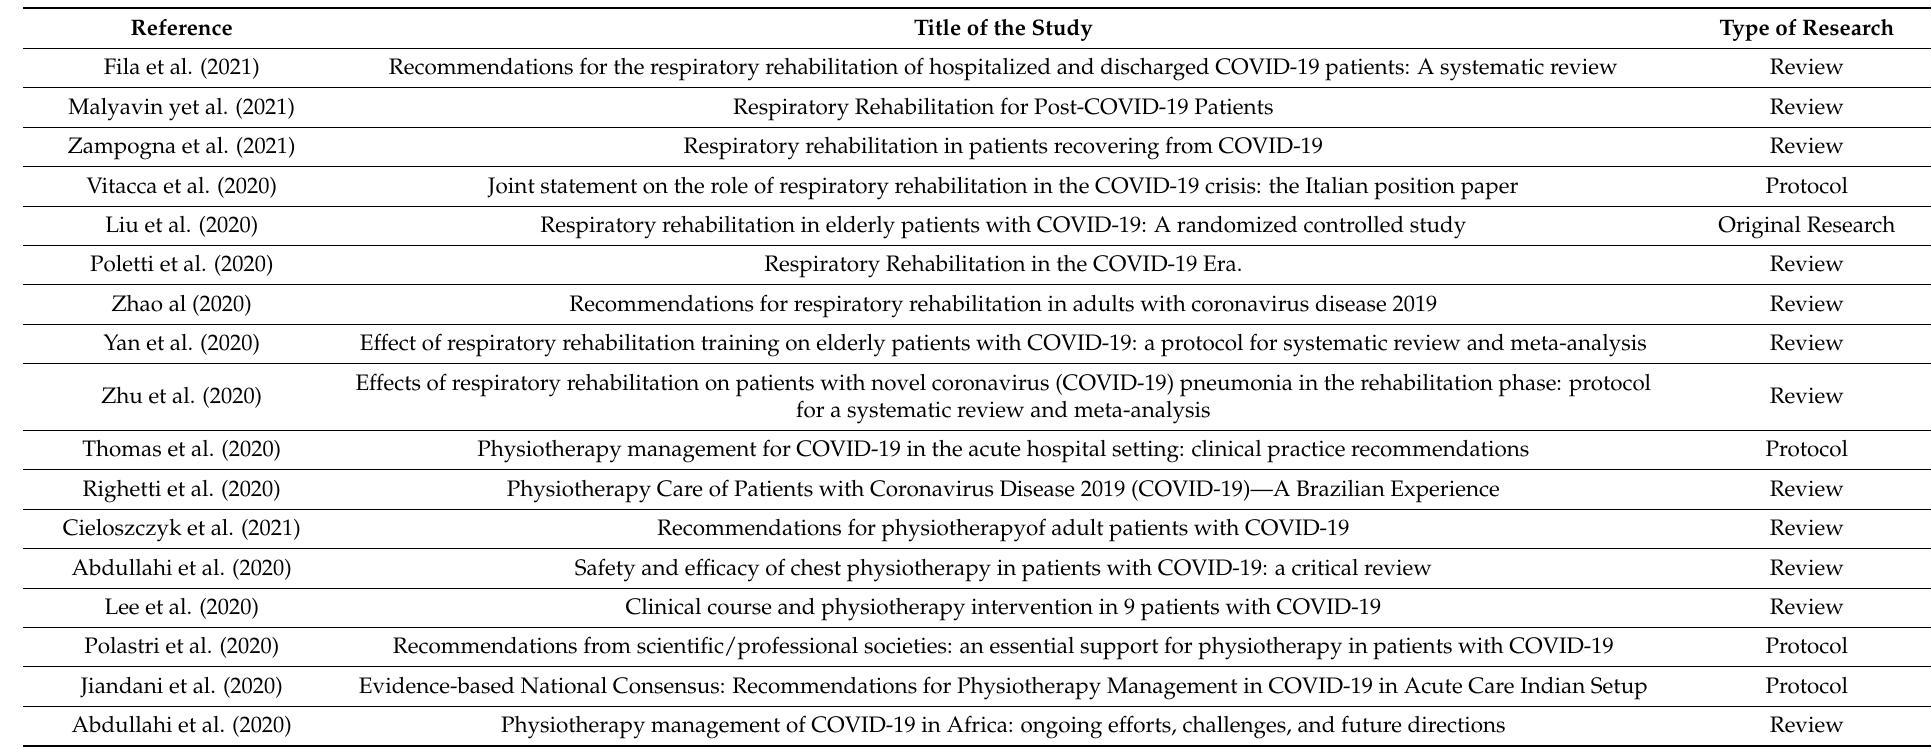
Table 1. Studies for clinical recommendations for COVID-19 physical therapy